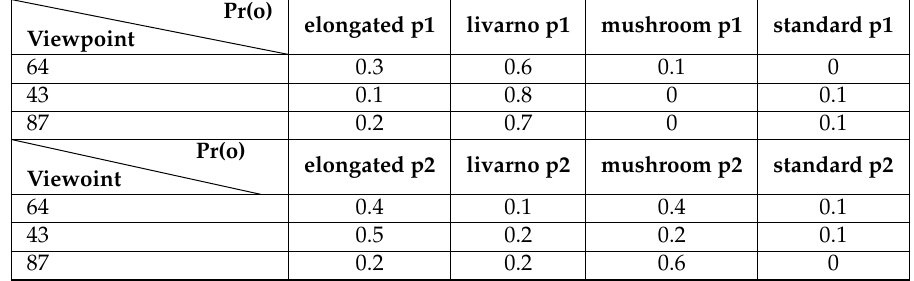
Table 3. Observation probability distribution in the multiple-position case. Top: position 1, bottom: position 2. The underlying object is of the livarno class on position 1, and elongated on position 2. Viewpoint